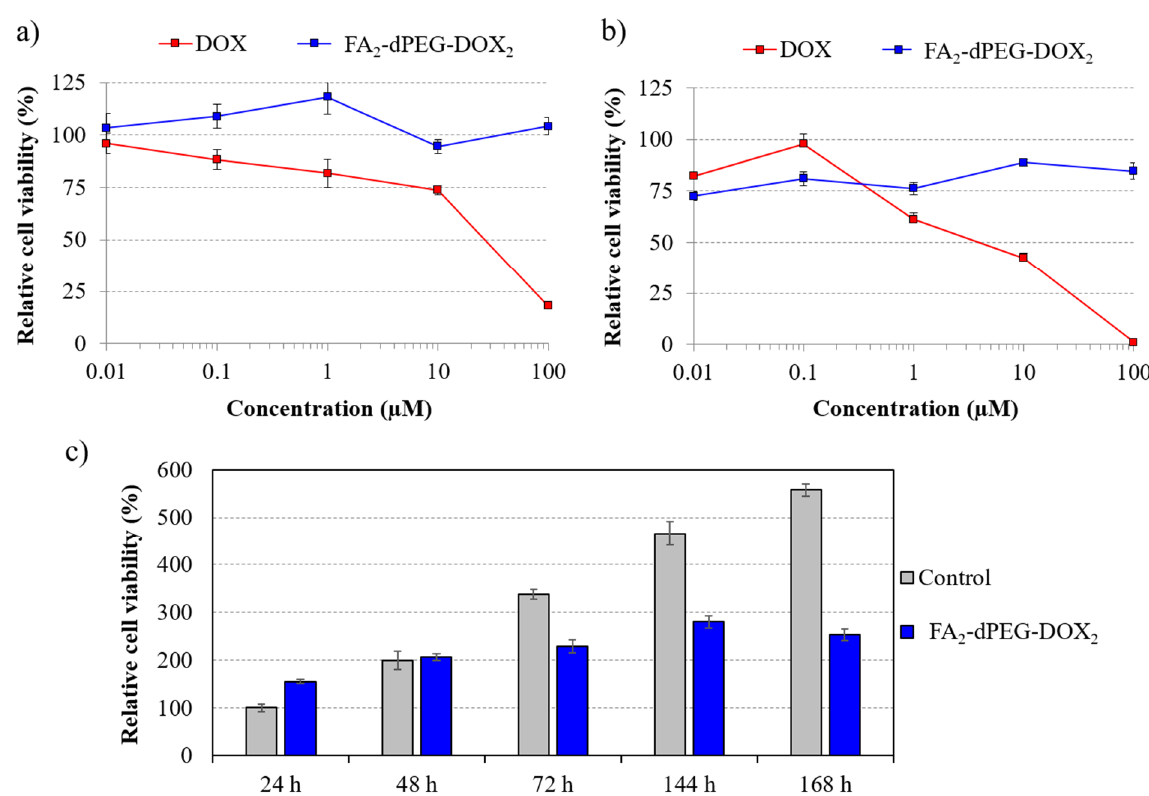
Figure 2. Results of the cytotoxicity assays. Relative cell viability of MDA-MB-231 cells vs. concentration of free DOX and FA 2 -dPEG-DOX 2 after 24 h-long ( a ) and 48 h-long ( b ) treatment. Long-term effect of FA 2 -dPEG-DOX 2 at 100 µM concentration on cell viability ( c ). All data were normalized to the viability value of untreated control measured 24 h after the beginning of the treatment.